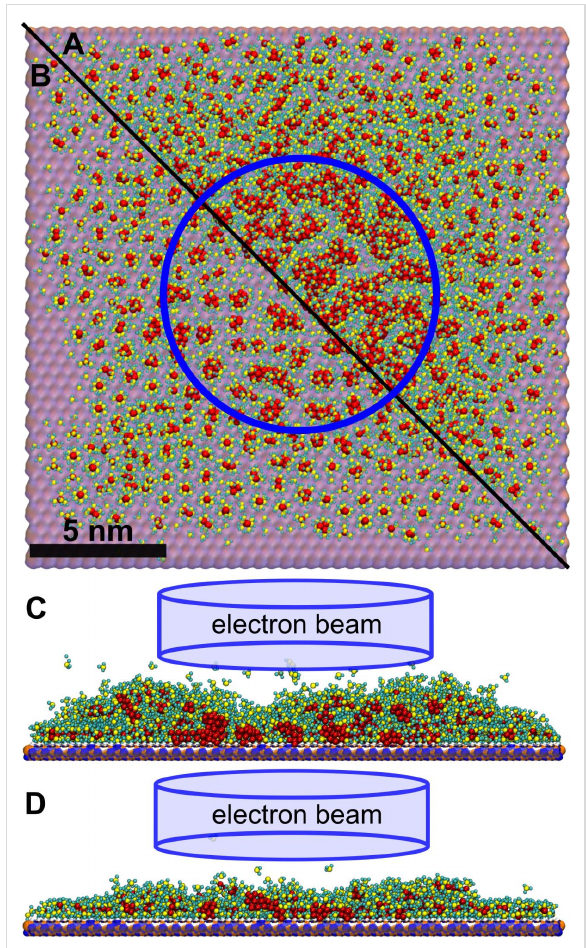
Figure 4: A snapshot of the multiscale IDMD simulation of a FEBID process using Pt(PF 3 ) 4 at the end of the 20th cycle (after 200 ns of the simulation). Panels (A) and (C) show top view and side view of a 6 nm thick slice through the beam center of the grown structure for an energy transferred to the medium during fragmentation of E dep = 300 kcal/mol with 223 precursor molecules added on average per FEBID cycle. Panels (B) and (D) show the corresponding views for the regime of E dep = 205 kcal/mol with 68 precursor molecules added on average per FEBID cycle. The scale bar is the same for all figures. The blue cylinder indicates the PE beam spot. The images have been rendered using “Visual molecular dynamics” software